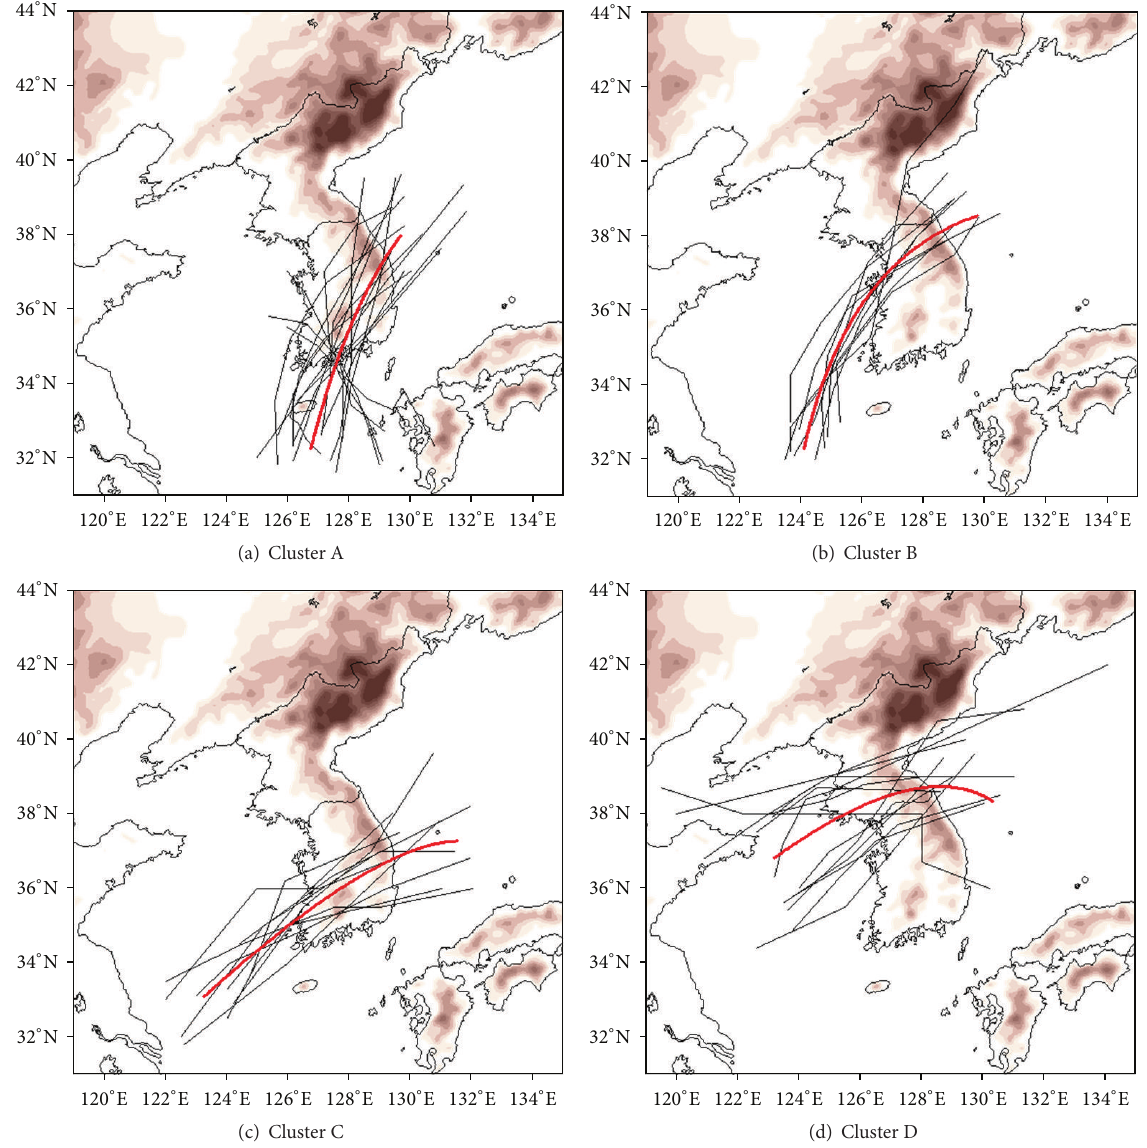
Figure 12: Same as Figure 11, but for four clusters. Thick red lines denote mean regression tracks. Shaded area indicates topography higher than 200 m above the sea